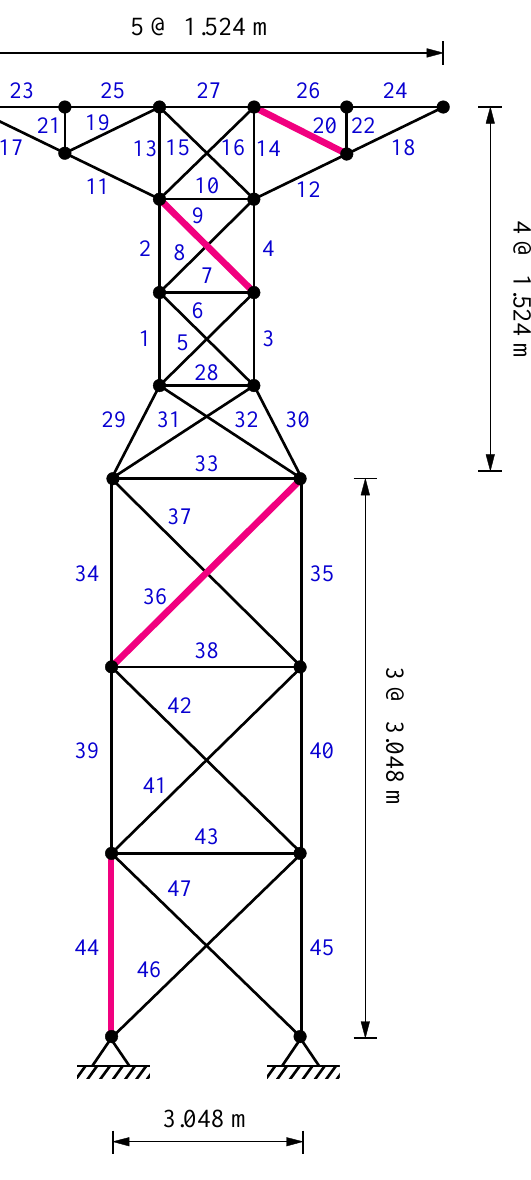
Figure 5. A 47-bar planar truss. Table 3. Statistical results of the damage identification for the 47-bar planar